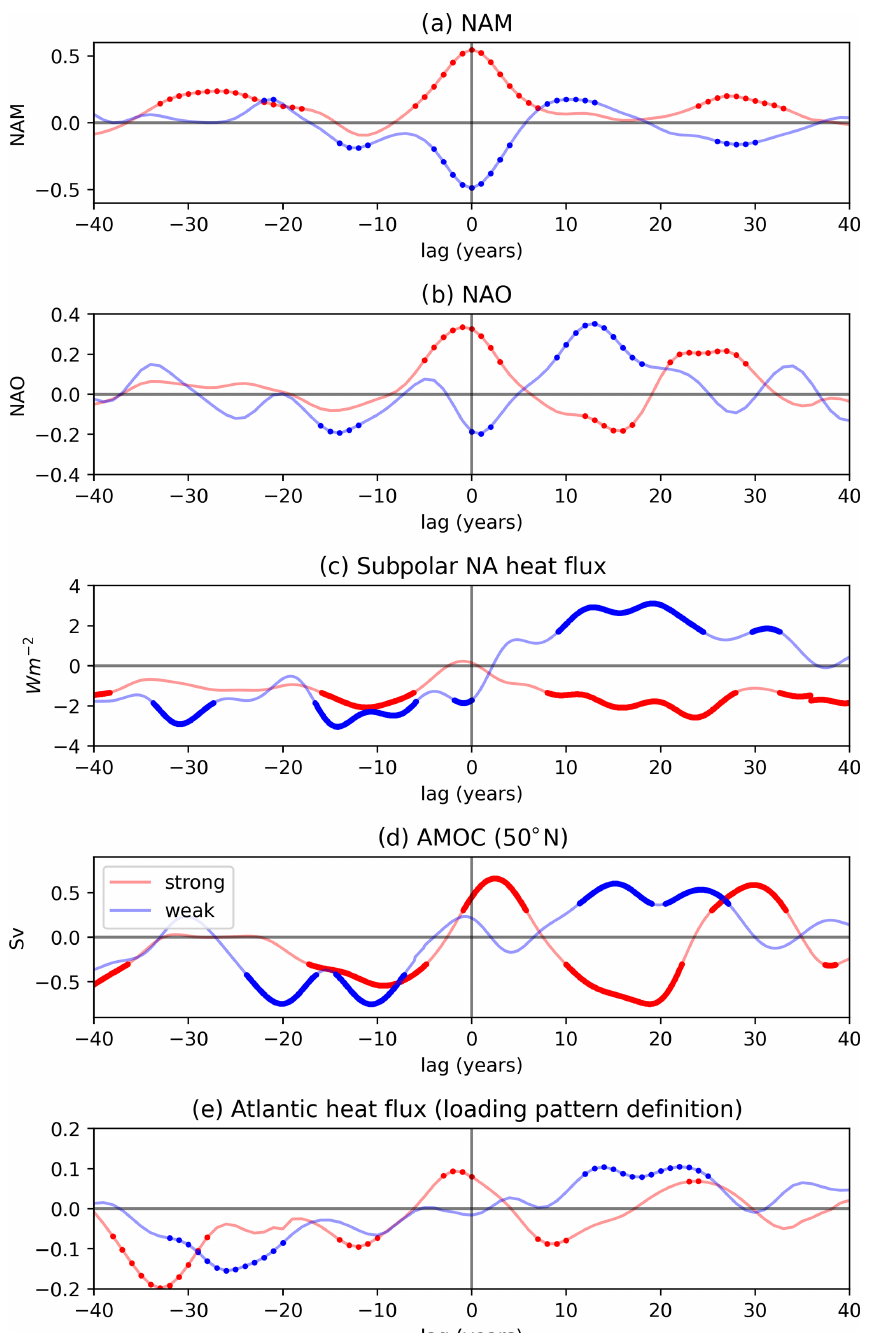
Figure 5. (a) Composites of (a) Gaussian smoothed NAM 10 , (b) NAO, (c) subpolar NA heat flux, (d) AMOC anomalies at 50 ◦ N, and (e) a NA heat flux index derived by projecting the Dec–Mar heat flux onto the response pattern in Fig. 6 that are associated with persistent vortex intervals of different types. On each subfigure, the red (blue) plots show the lead/lag responses to composites of strong (weak) persistent NAM 10 intervals. Solid dots denote composite anomalies are significant to the 95% level under a two-tailed Student’s t test.